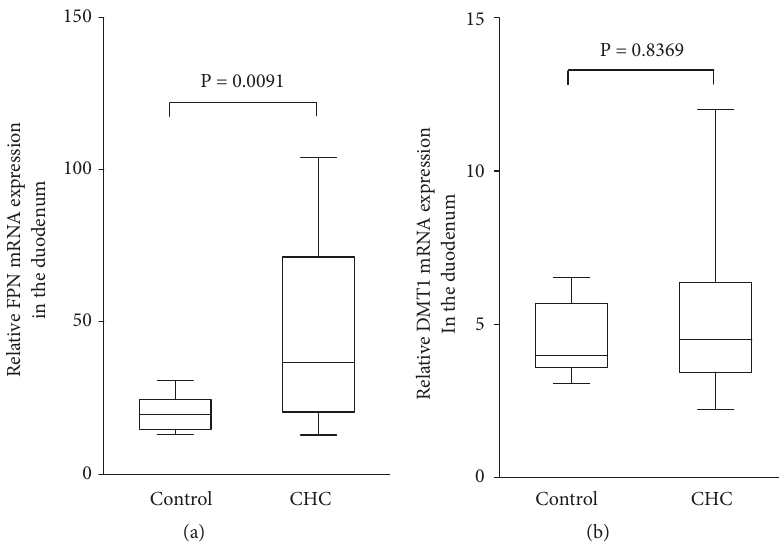
Figure 3: FPN and DMT1 mRNA expression in the duodenum. Relative mRNA expression levels of FPN (a) and DMT1 (b) in the duodenum were measured by Taqman real-time PCR. FPN mRNA in the CHC group was significantly upregulated compared with control participants (P = 0.0091; Wilcoxon-Mann-Whitney U test). Relative mRNA expression levels of DMT1 were measured by Taqman real-time PCR (b). There was no significant between-group difference (P = 0.8369; Wilcoxon-Mann-Whitney U